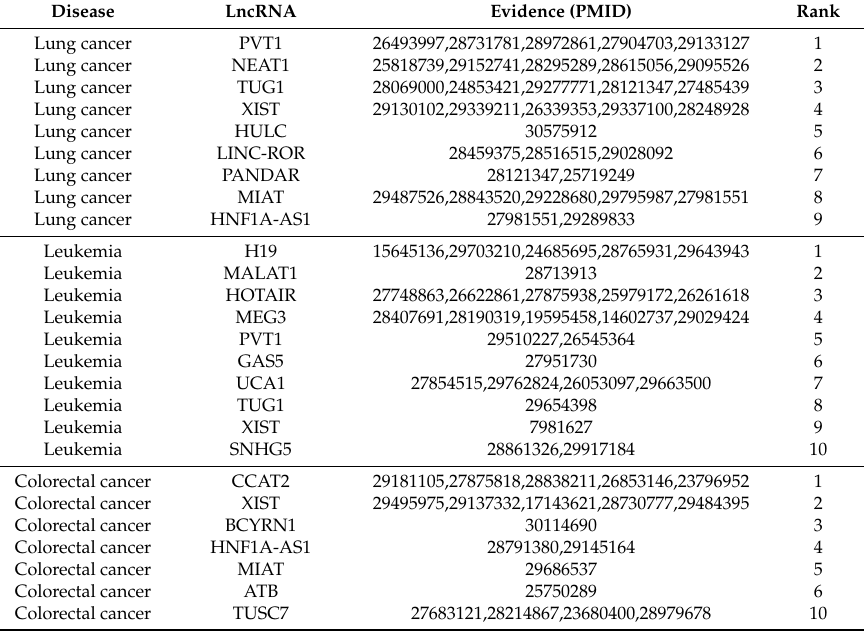
Table 1. Top 10 potential lung cancer, leukemia, and colorectal cancer-related lncRNAs predicted by NBLDA and confirmations for these predicted associations provided by the Lnc2Cancer database and the studies in the PubMed